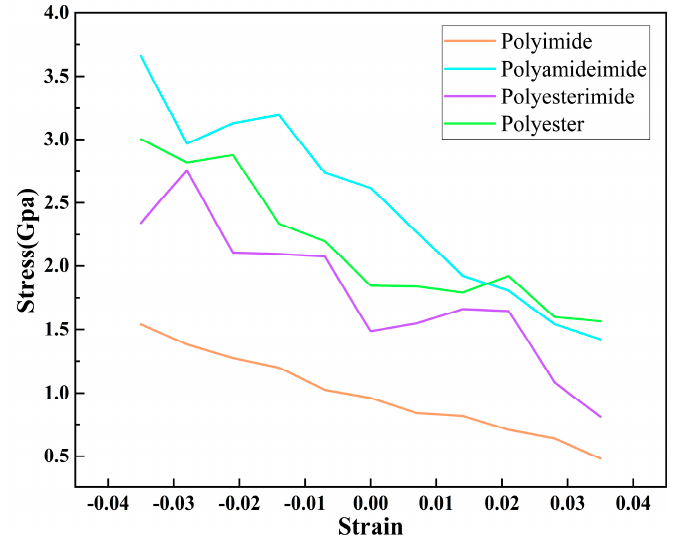
Figure 7. Amorphous cell stress–strain curves for PAI, PET, PEI, and PI.